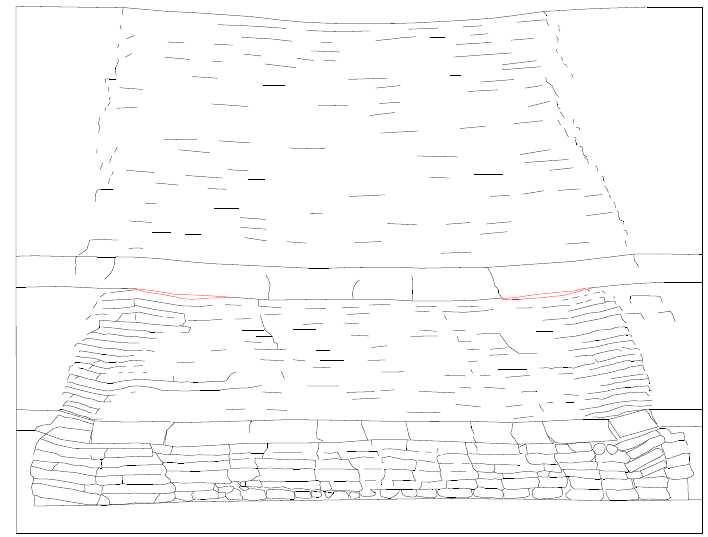
( b ) Figure 11. Borehole dislocation and recovery: ( a ) dislocation due to block rotation; ( b ) dislocation recovery due to the reverse rotation of the block. (2) If the drill hole is in the middle of the working face, when the rock strata near the drill hole break for the first time, the borehole wall shows stepped dislocation. However, as the working face continues to advance, the rock strata break periodically, and the bro- ken blocks will reversely rotate, causing the dislocation of the internal surface of the bore- hole to gradually reduce or even recover to its initial state. (3) Specifically, the borehole may be blocked as shown in Figure 10d. There are two main reasons. First, the borehole is located at the mining boundary, and the turning angle of the broken block is too large. Second, the borehole is close to the collapse zone, and the surrounding rock strata break seriously, so the borehole is completely damaged after min-